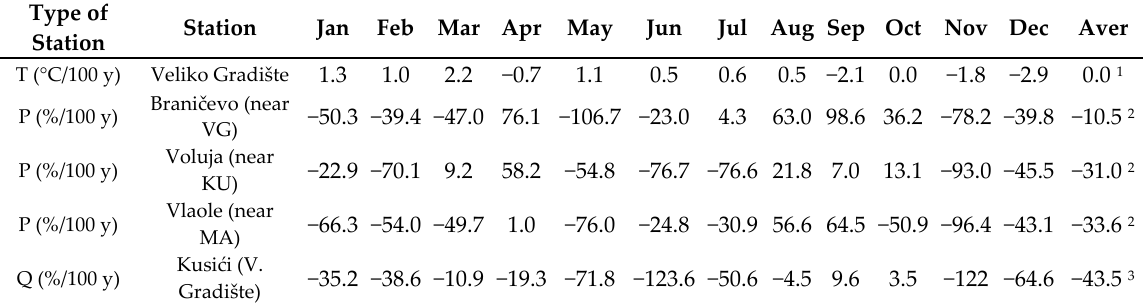
Table 1. Registered 1949–2006 trends by month and annual